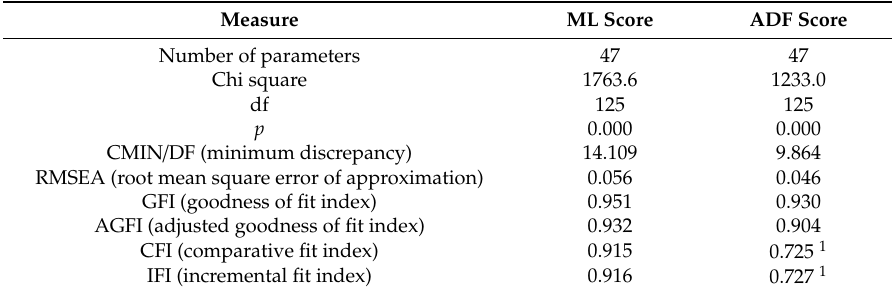
Table 10. Characteristics and goodness-of-fit statistics for the structural equation